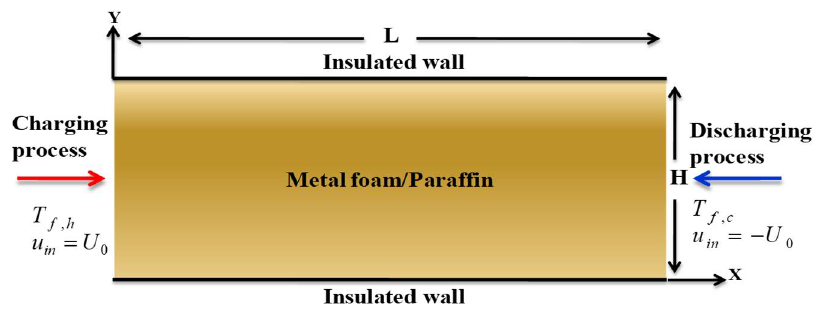
Figure 1. Physical Figure 1. Physical model.